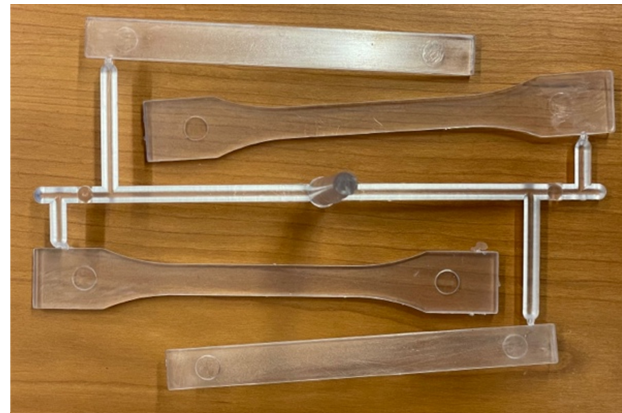
Figure 8. Example of the geometry of the injected geometry.